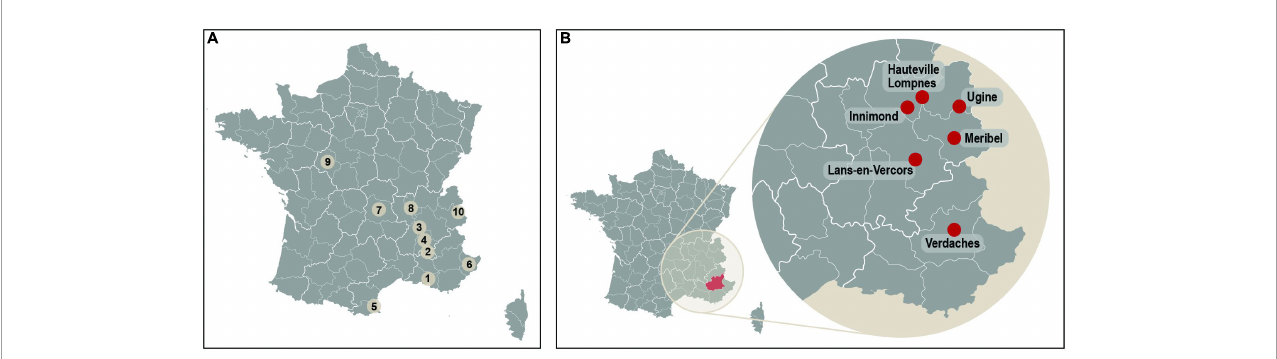
FIGURE4 (A) Geographic distribution of the conjugal amyotrophic lateral sclerosis cases. The French territory is divided on the map into its different départements . Each conjugal case is represented by its number in the text. #1, Bouches-du-Rhône; #2-4, Drôme; #5, Pyrénées-Orientales; #6, Alpes-Maritimes, #7, Puy-de-Dôme; #8, Rhône; #9 Indre-et-Loire, #10 Montchavin-Les Coches. Modified from Corcia et al. (2003) to include data from Lagrange et al. (2021b). (B) Location of genetically confirmed samples of G. gigas Krombe. Cooke collected from woodland conifers in S.E. France. Left: Alpes-de-Haut-Provence, Colmars, Ratery. Right: Ain, Hauteville-Lompnes, Col de la Berche; Ain, Innimond, Plaine du Bief; Isere, Lans-en-Vercors, Combe de Servagnet; Savoie, Ugine, La Mollette; Savoie, Les Allues, Altiport de Méribel; Alpes-de-Haut, Verdaches, Haut-Bès. (Sourced from the Illinois Natural History Survey Fungarium, University of Illinois, January